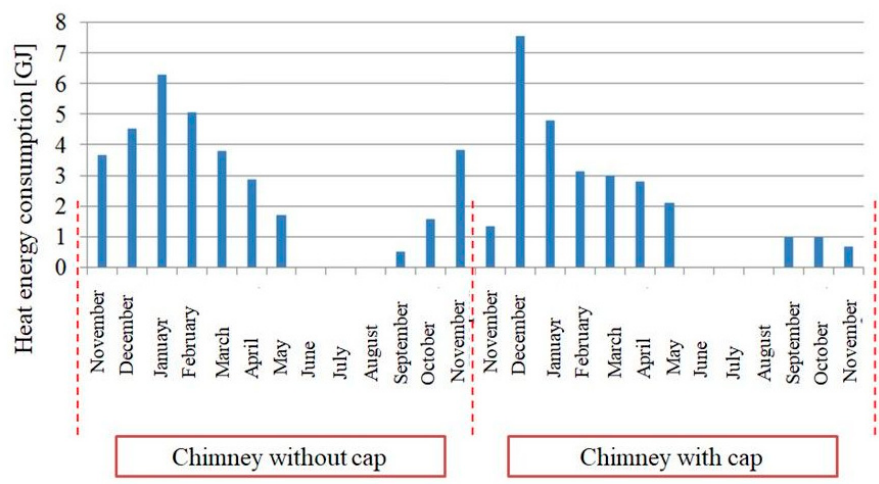
Figure 22. Comparison of thermal energy consumption for heating a building.